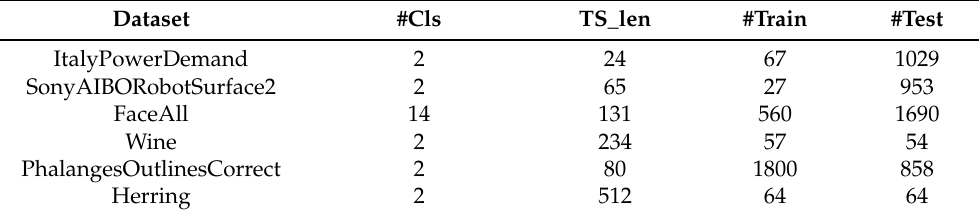
Table 1. The chosen datasets, having varying characteristics, for the evaluation of the genetic operators’ efficiency. #Cls = number of Classes, TS_len = length of Time Series, #Train = number of Training time series, #Test = number of Testing time